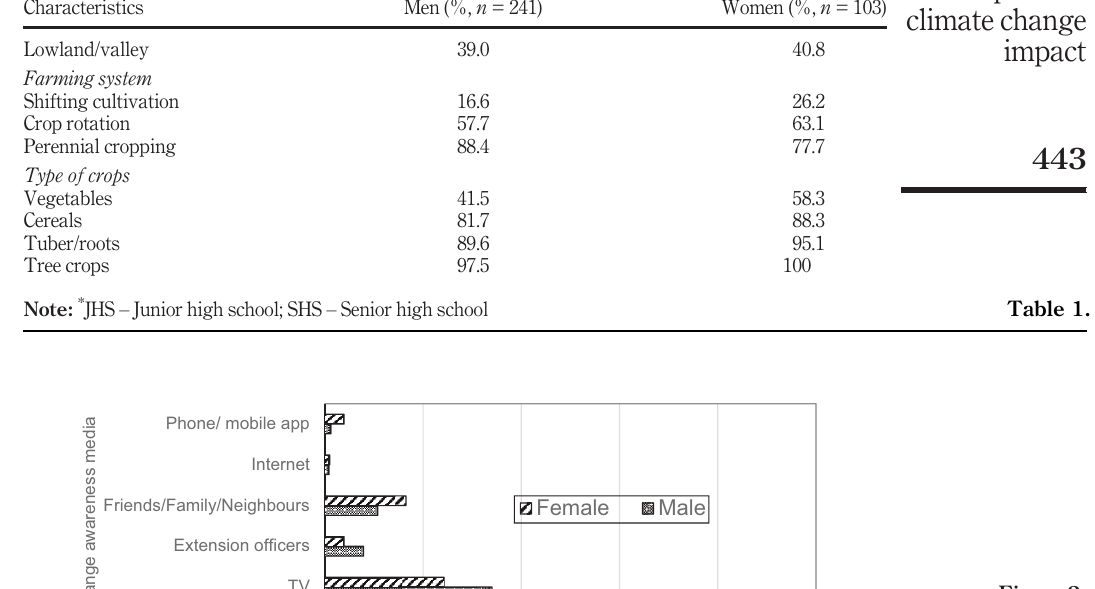
Figure 2. Source of